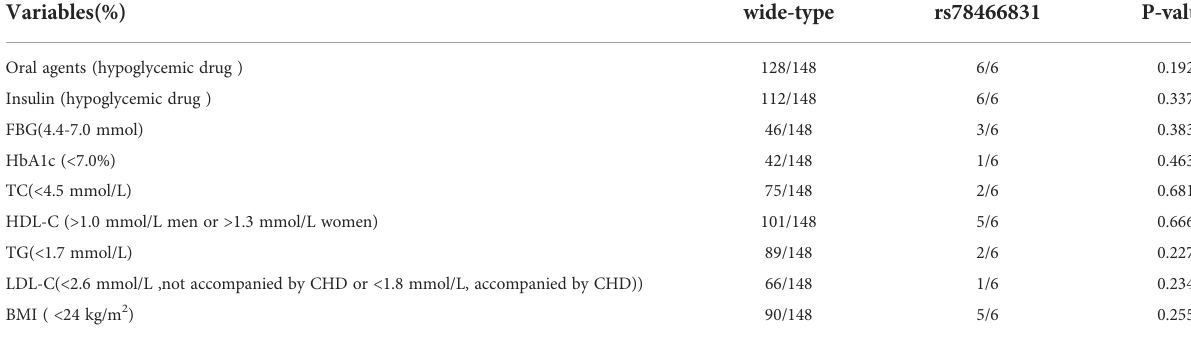
TABLE 4 Therapeutic drug and target value achievement rates of the wild-type and rs78466831 patients with T2DM.